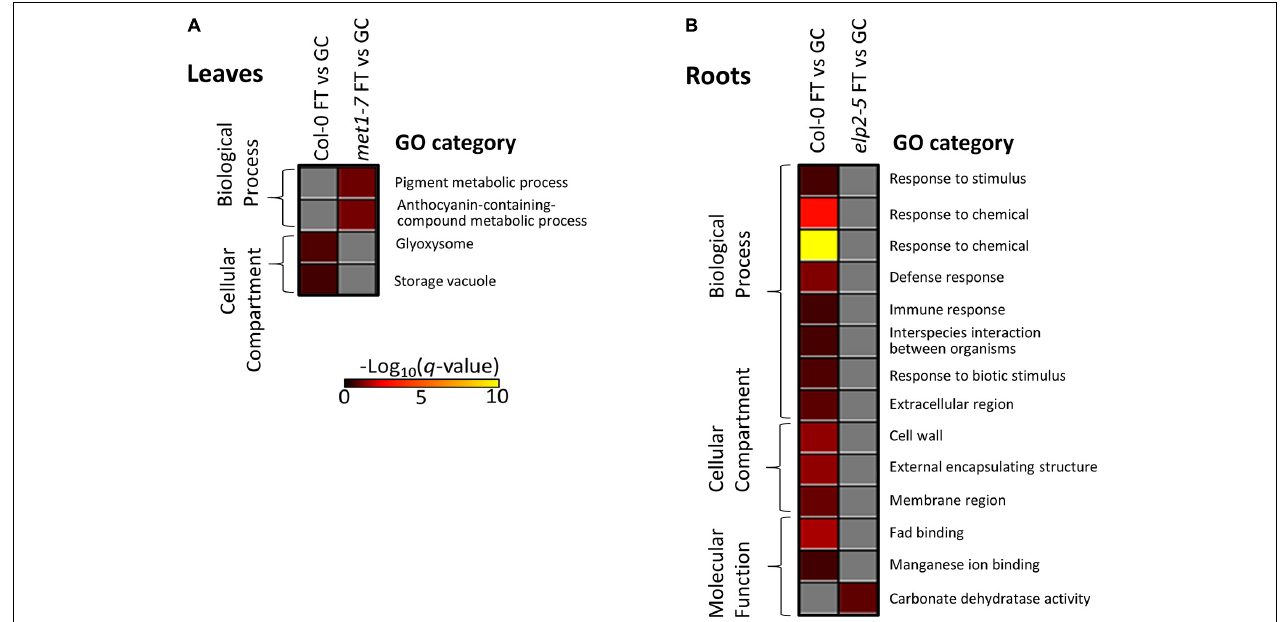
FIGURE 12 | Gene ontology enrichment analyses of spaceflight (FT) vs ground control (GC) DEGs-DmCs in each genotype. (A) The heatmap shows the GO terms that were enriched for in the DmC-DEG heatmap ( Figure 10 ) for the leaf tissue in all three genotypes. In leaves, elp2-5 did not have any enriched GO terms. (B) The heatmap shows GO terms that were enriched for in the DmC-DEG heatmap ( Figure 11 ) for the root tissue in all three genotypes. In roots, met1-7 did not have any enriched GO terms. The scale bar represents the negative Log 10 of the q -values (corrected p -values) for the GO terms’ enrichment within each list of DmC-DEGs. The q -value cutoff was set at 0.05. Higher values in the scaling indicate higher significance of the